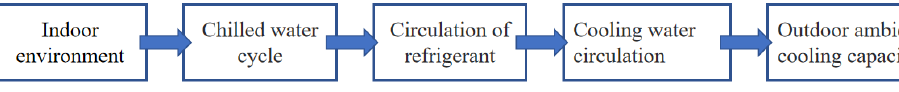
Figure 3. Heat transfer diagram. The heat transferred by the cooling water is greater than the heat removed by the chilled water from the room, and the difference between the two is the heat generated when the chiller performs its function. Figure 4 shows a line graph based on some of the data collected by a third party, from which the principle can be verified in a clear manner. Figure 4. Cooling side versus refrigeration side cooling capacity. 3. Load Forecasting Models 3.1. The Overview of Common Forecasting Models The change in air conditioning load is a typical nonlinear change with stochastic char- acteristics, such as dynamic, time-varying, multi-disturbance, and uncertainty [26]. Air conditioning loads are also affected by operating hours, system type, weather conditions, and other factors [27]. Therefore, it is very difficult to accurately analyze the process of load variation. To achieve predictive control of a central air conditioning system, we first need an accurate forecast of the cooling load for each hour of the following day. Secondly, the real-time load of the central air conditioning system can be more precisely regulated if the time-by-time cooling load at the next moment can be accurately predicted. It is still expected to achieve more than 90% accuracy through the established model, which can basically eliminate the blindness and hysteresis of chilled water variable flow control. The widely used modeling and analysis methods include regression analysis, time series analysis, support vector machines, and artificial neural networks. When carrying out load forecasting, the operational characteristics of specific projects and the standards